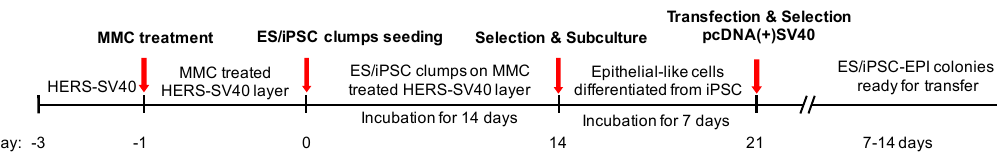
Figure 1. Experimental scheme for the differentiation of human pluripotent stem cells into dental epithelial-like cells. Mitomycin C (MMC)-treated Hertwig’s epithelial root sheath/epithelial rests of Malassez (HERS/ERM) cells were used as a feeder layer for epithelial-like cell differentiation. Two weeks after the seeding of human induced pluripotent stem cell (hiPSC) clumps on the feeder layer, differentiated epithelial-like cells were collected and characterized. To overcome the limited lifespan of epithelial-like cells, the cells were transfected with an SV40 gene. Immortalized cell lines selected through G418 were characterized by morphology and genetic/immunophenotypic characteristics.